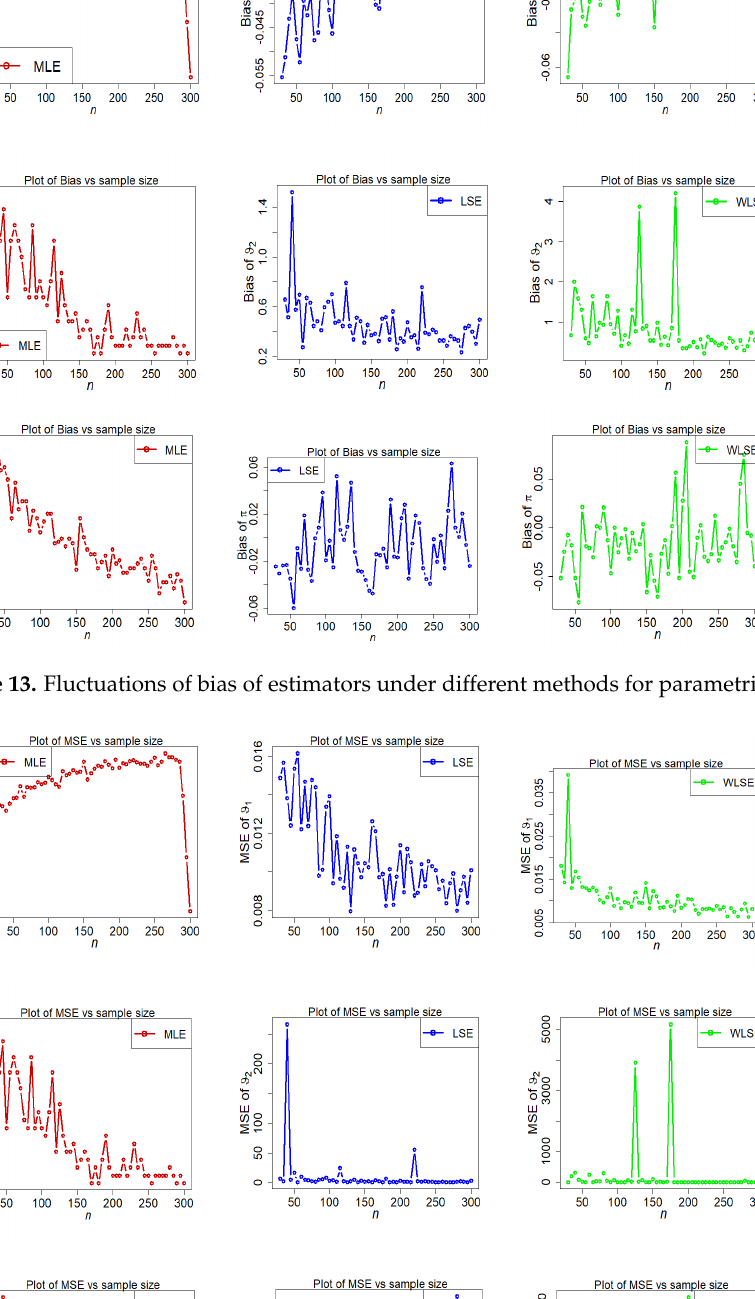
Fig. 12. Fluctuations of MSE of estimators under di⁄erent methods for parametric set III.